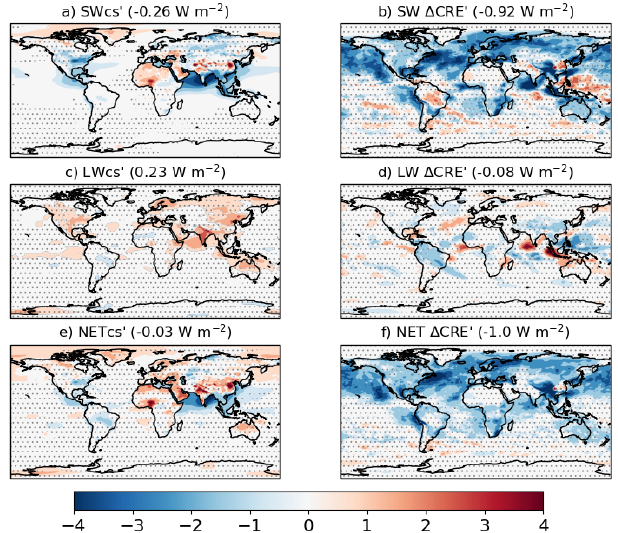
Figure 12. Global distributions of the PD NTCF ERF compo- nents at the top of atmosphere (TOA) relative to the PI period, i.e. piClim-NTCF minus piClim-control , based on Eq. (8): (a) SW (cid:48) cs , (b) SW CRE (cid:48) , (c) LW (cid:48) cs , (d) LW CRE (cid:48) , (e) NET (cid:48) cs , and (f) NET CRE (cid:48) . Global mean values are shown in brackets. Regions where the ERF components are outside the 95% confidence level are stip- pled. Units in Wm − 2 .